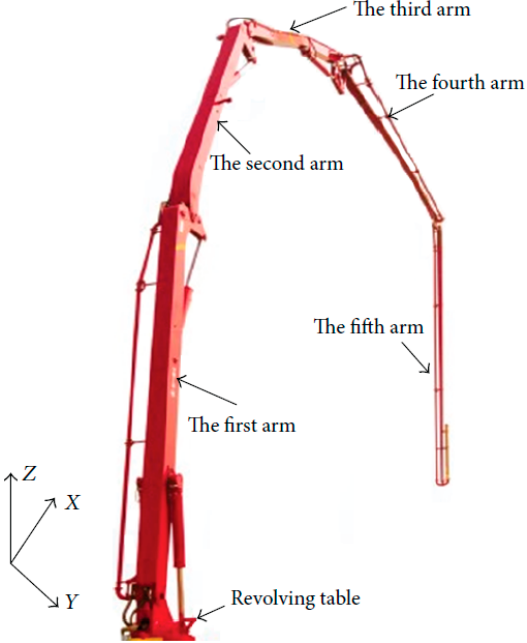
Figure 6. Boom system of truck-mounted concrete pump [30].